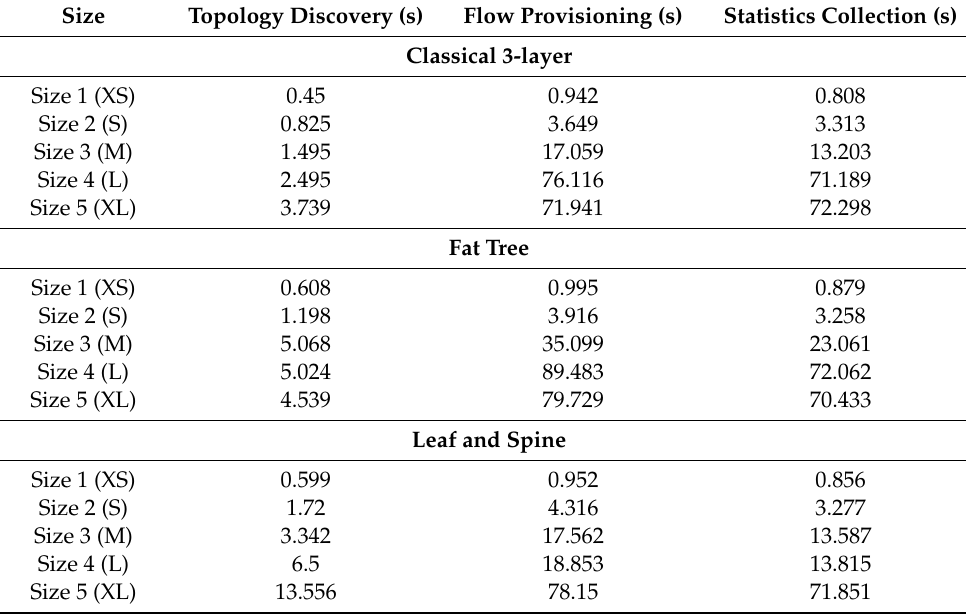
Table 3. Performance evaluation of SDN application.